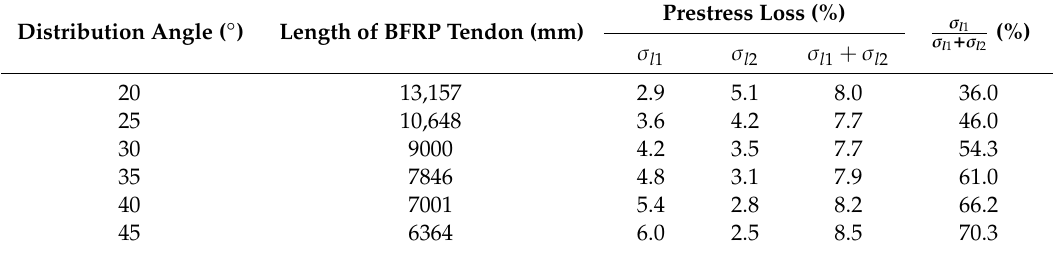
Table 3. Theoretical prestress loss of BFRP tendons given the slab width of 4.5 m. Distribution Angle ( ◦ )